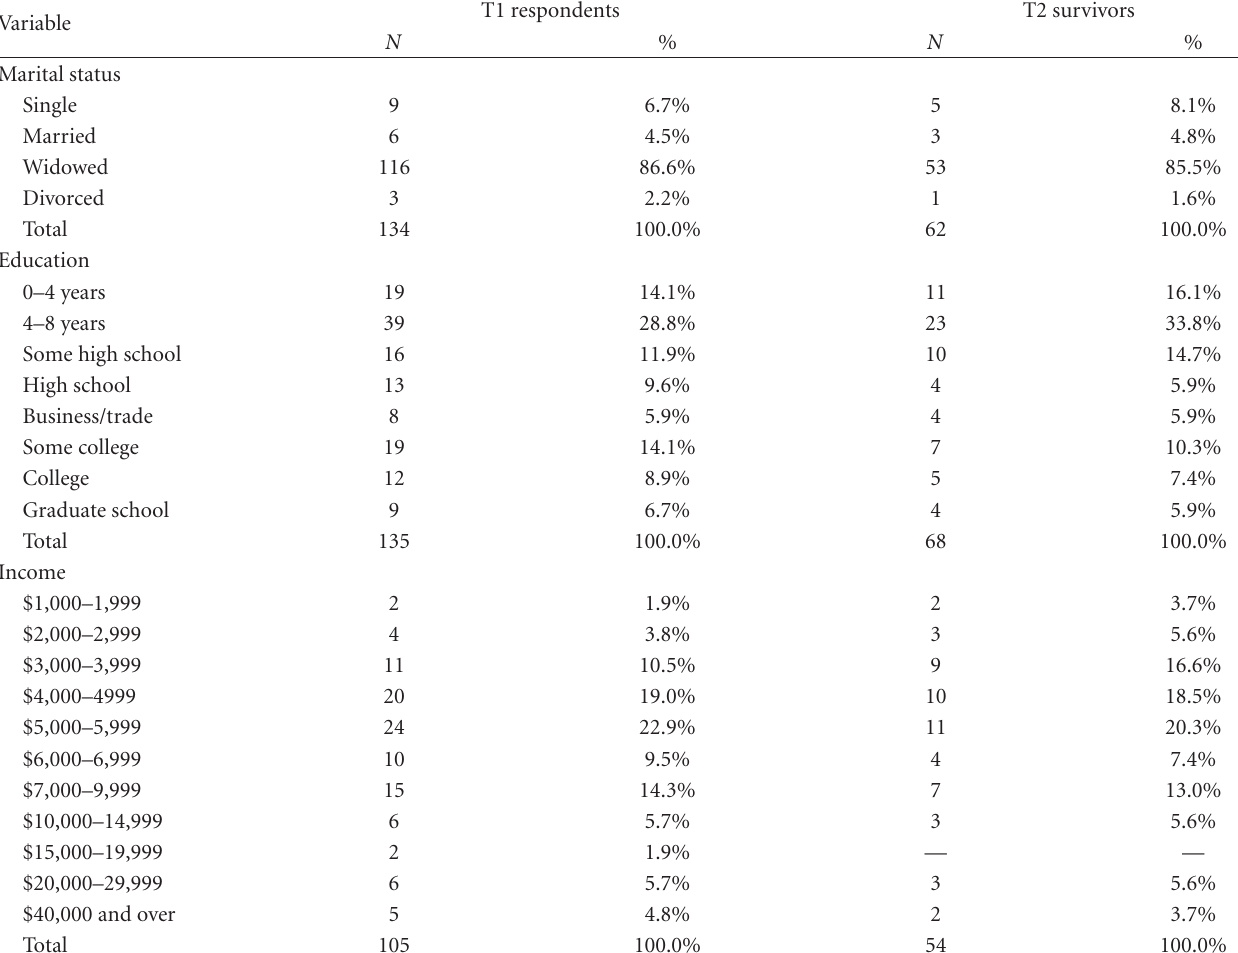
Table 1: Frequencies of demographic characteristics among centenarian respondents at Time 1 ( N = 136) and Time 2 survivors ( N = 68).